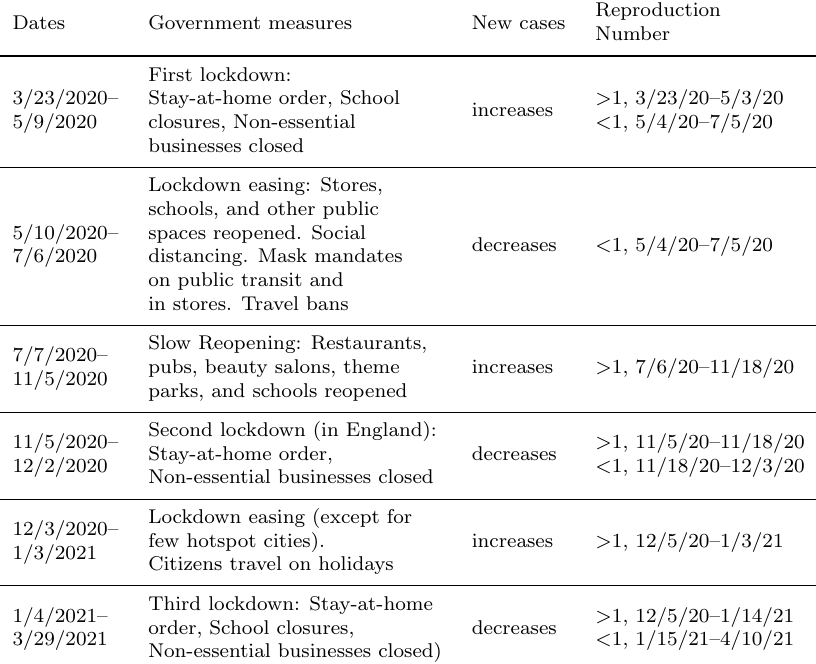
Table 1. Timeline of COVID-19 spread and mitigation activities in the UK Dates Government measures New